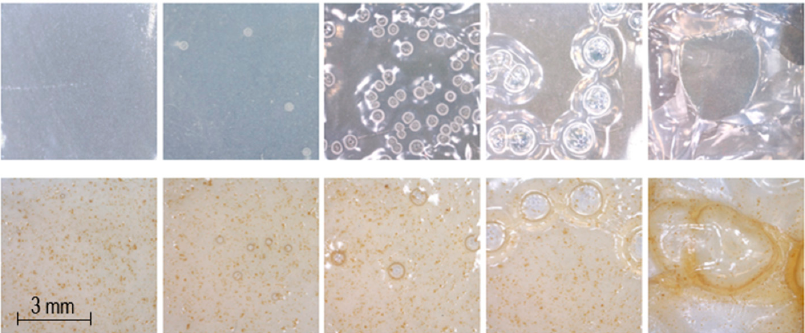
Figure 10. Microscopy pictures of drug-loaded films (upper row) and drug-loaded films with liver powder (lower row). From the left, after drying at room temperature, 40, 60, 80, and 100 °C. Taken with a handheld digital microscope.